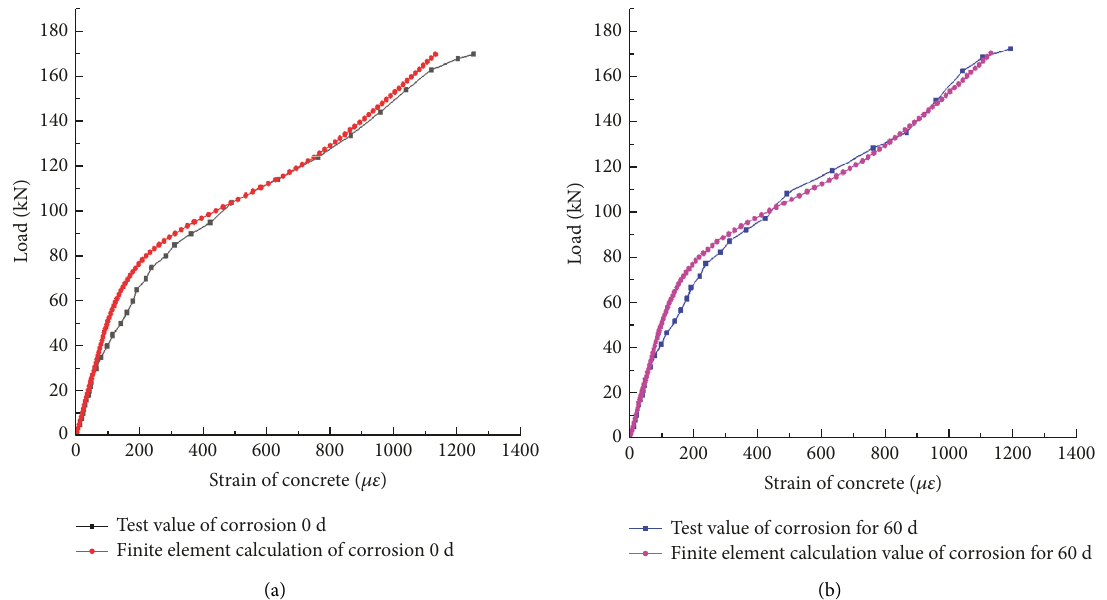
Figure 10: Load strain diagram of beam bottom concrete. (a) Load strain diagram of corrosion 0 d. (b) Load strain diagram of corrosion 60d.